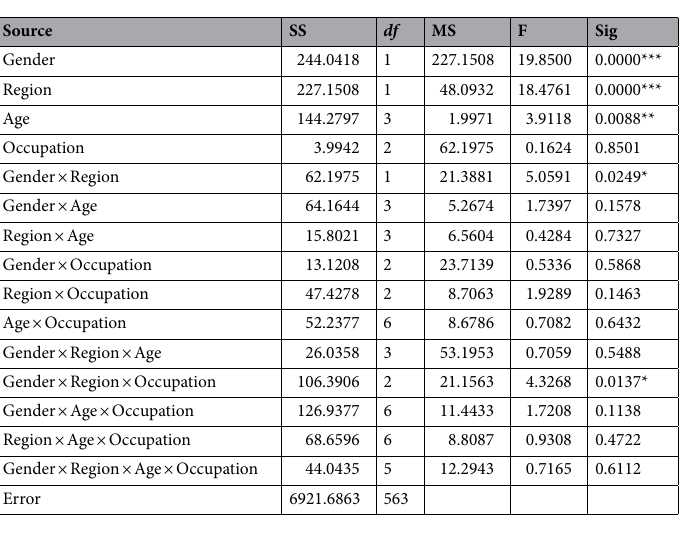
Table 11. Four-way analysis of variance of avoiding human contact with gender, region, age and occupation. * p < .05, ** p < .01, *** p < .001.